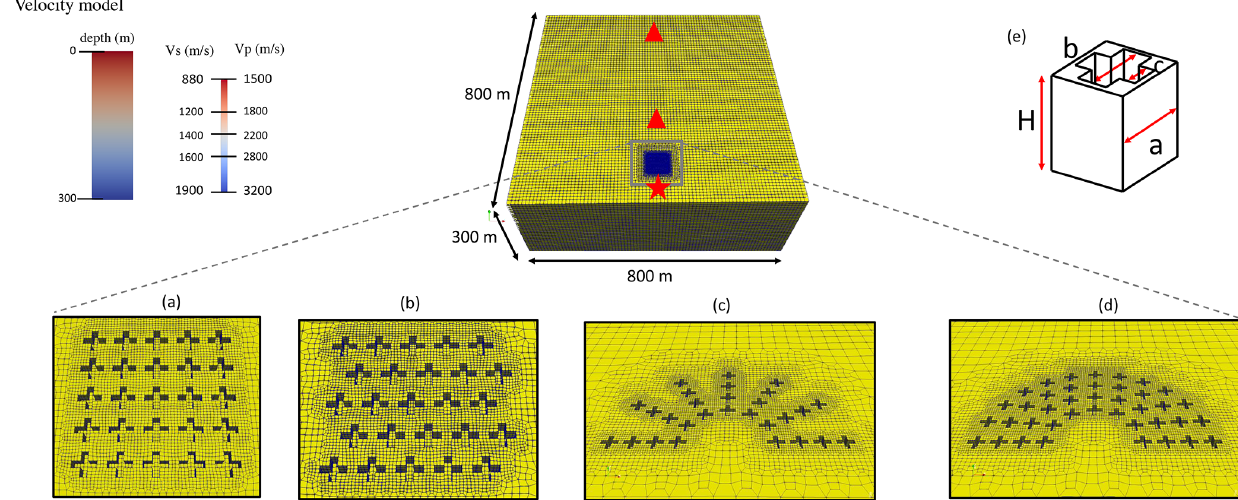
Figure 1. Mesh examples of the cross-shaped cavities used for the different numerical simulations. The red star indicates the place of the WT and the red triangles the places of the seismic stations. Note that we also considered seismic stations towards the sides of the box. (a) Grid of 5 × 5 cavities distributed in an area of 50 × 50m 2 . (b) Same as (a) but with two shifted lines of cavities. (c, d) Cross-shaped cavities arranged in a half-circular arrangement. (e) Unit cell detailing the dimensions of the cell, a , b and c and depth H .